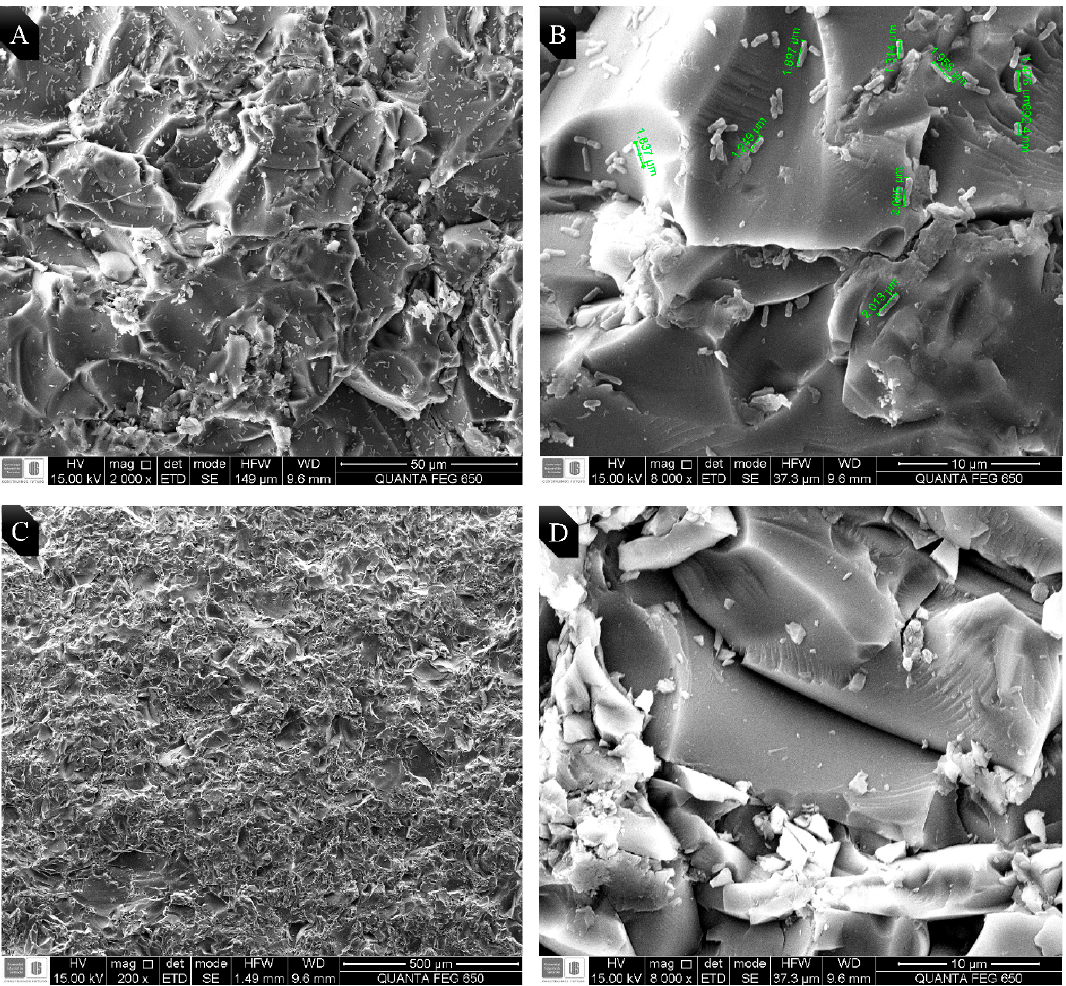
Figure 3. Micrographs of E. coli O157:H7 on frosted glass coupons obtained by SEM. ( A ) Control biofilm (2000 × ). ( B ) Magnification of control biofilm (8000 × ). ( C ) Biofilm of E. coli O157:H7 treated with LOC (0.5 MIC50) (200 × ). ( D ) Magnification for biofilm treated with EO LOC (0.5 MIC50) (8000 ×